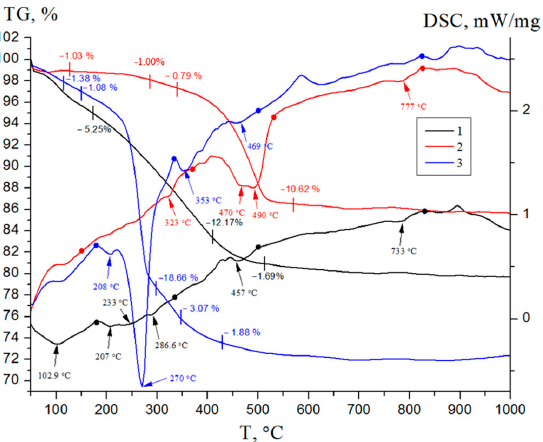
Figure 9. Scheme of different morphology nanostructure formations during water oxidation of Al/Ag nanoparticles under different conditions.